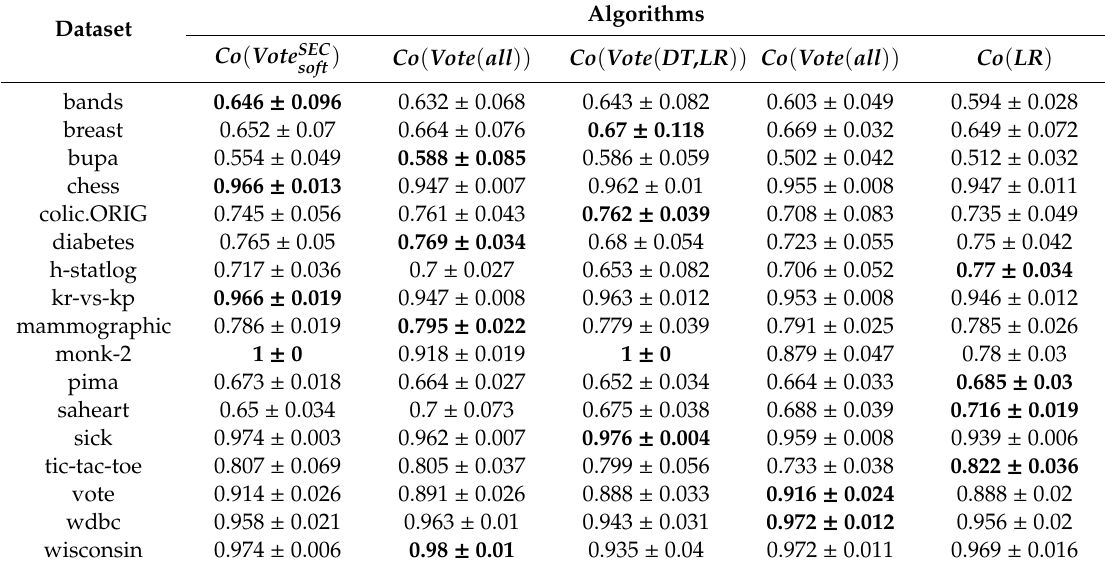
Table 4. F 1 -score ( ± stdev) values for the best five variants (labeled ratio 10%).